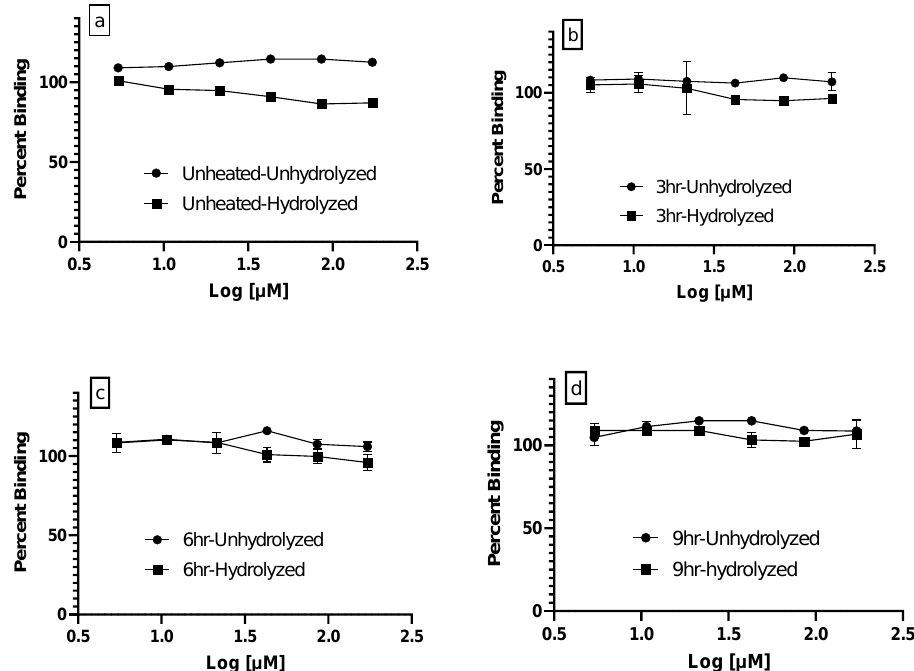
Figure 4. PPAR γ binding of unhydrolyzed and hydrolyzed vegetable oil. Mean ± SEM of PPAR γ ligand binding curves of unheated oil ( a ), 3H heated oil ( b ), 6H heated oil, ( c ) and 9H heated oil ( d ). Within each graph, the dark circle represents unhydrolyzed and the dark square represents oil subjected to alkali hydrolysis. The molar concentration of soy oil was determined in previously published work. There were no significant differences in the binding affinity between the unhyrolyzed and the hydrolyzed oils in the unheated and heated oils.